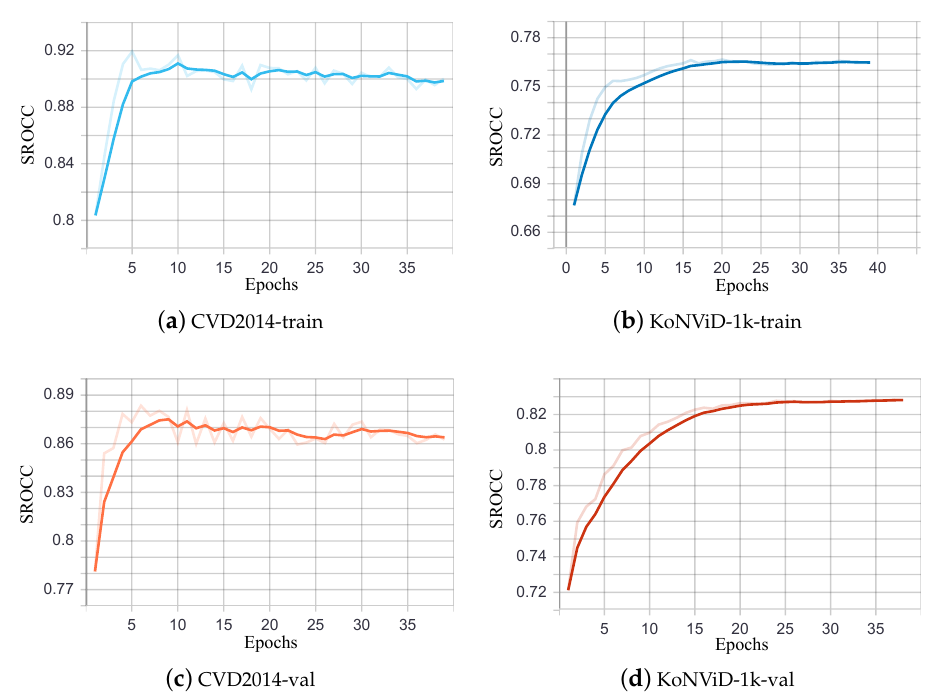
Figure 9. SROCC performance in each dataset over the training and validation epochs.